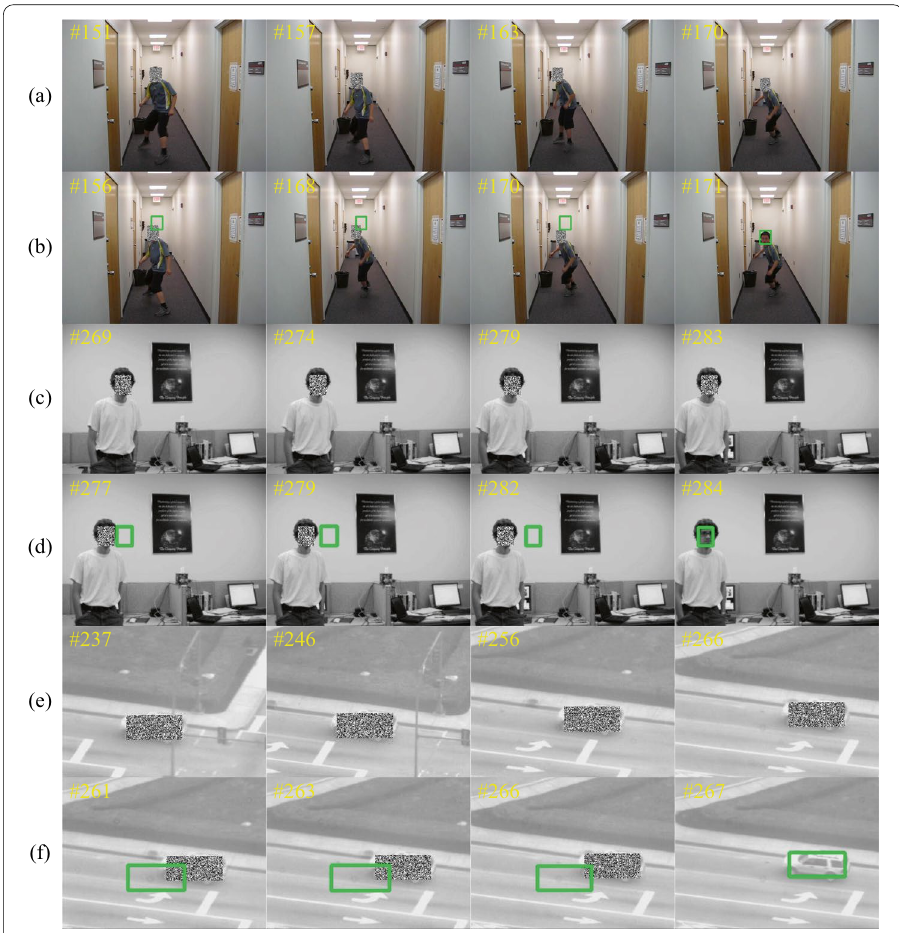
Fig. 16 a Tracking video sequence boy with an artificial mask; b recovery tracking result based on the tracking video sequence boy with an artificial mask; c tracking video sequence David2 with an artificial mask; d recovery tracking result based on the tracking video sequence David2 with artificial mask; e tracking video sequence Suv with an artificial mask; f recovery tracking result based on the tracking video sequence Suv with artificial